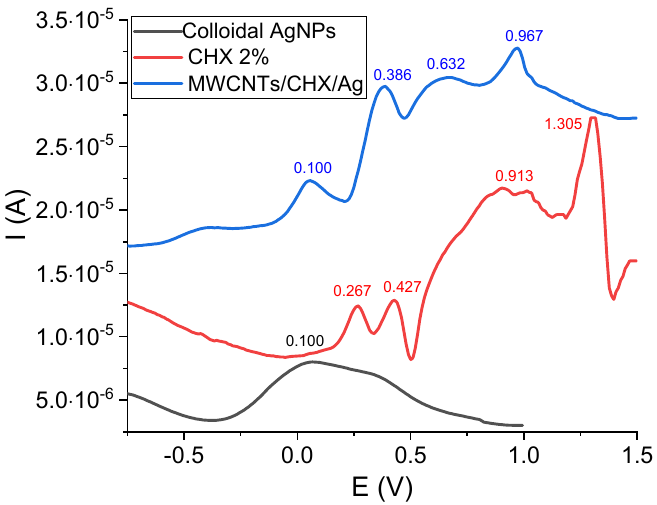
Figure 2. Differential pulse voltammetry of colloidal AgNPs, CHX 2% solution and the mixture CNTs/CHX/AgNPs.